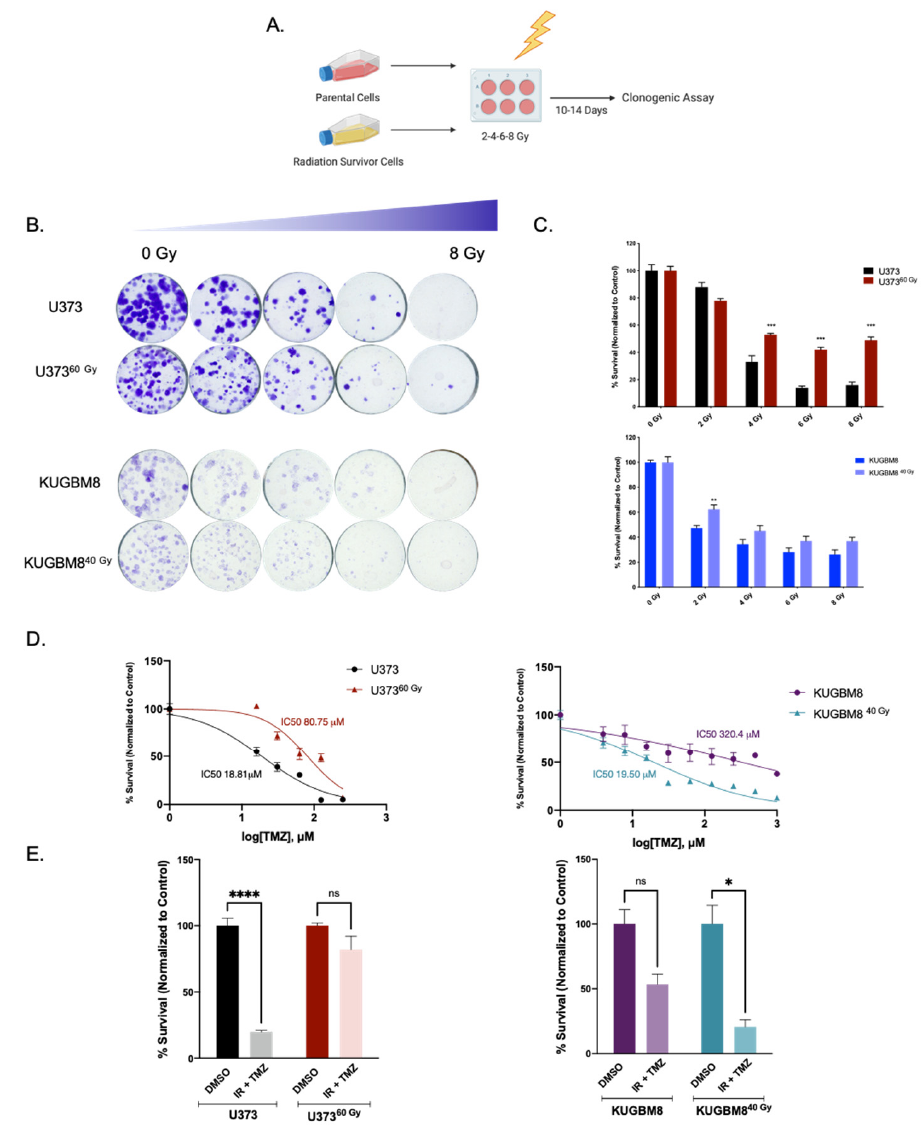
Figure 2. Effect of secondary IR treatment varies among different IR-Surv cells. ( A ) Schematic representation of experimental set up to test the effects of secondary ionizing radiation exposure (generated by Biorender.com). ( B ) Representative images of clonogenic assay of U373-U373 60 Gy and KUGBM8-KUGBM8 40 Gy cells upon single treatment with increasing doses of IR. ( C ) Quantification of colony numbers of naïve and IR-Surv U373 and KUGBM8 cells. ( D ) Dose-response curves of naïve and IR-Surv U373 and KUGBM8 cells upon TMZ treatment for 2 days. ( E ) Cell viabilities of cells 7 days after TMZ and IR combination treatment. (ns denote not significant, for p -values, *, **, ***, and **** denote p < 0.05, p < 0.01, p < 0.001, and p < 0.0001, respectively, two-way